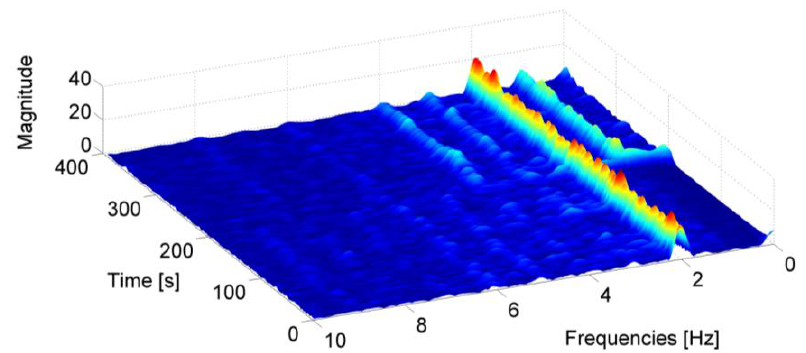
Figure 4. Spectrogram of the accelerometer signal for a walking user with the IMU in the